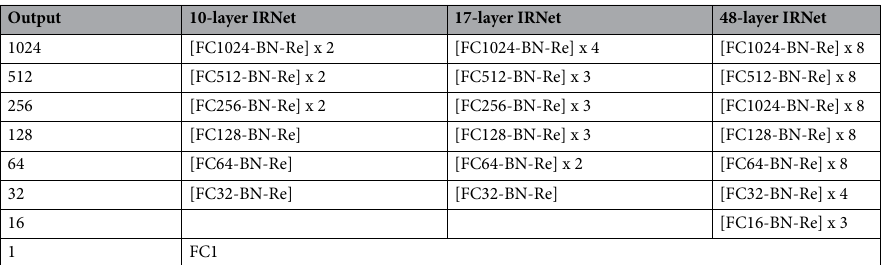
Table 4. Detailed model architecture configurations for different depths of network